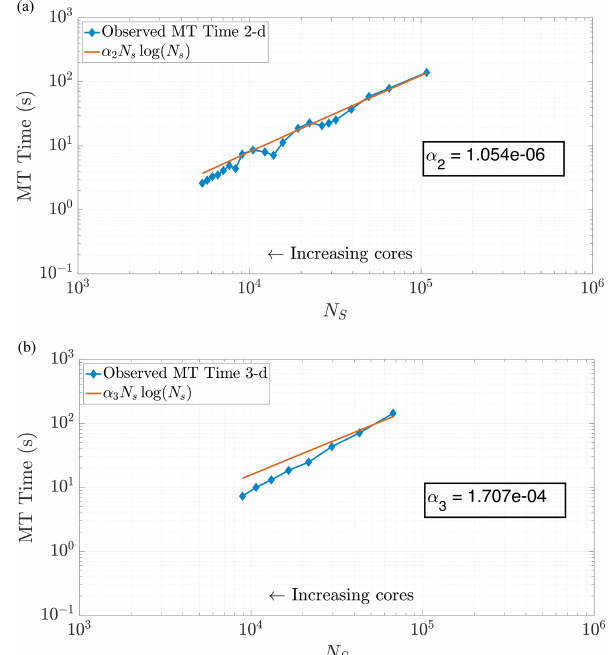
Figure 6. Plots of run time in the MT portion of benchmark runs. Note the similar behavior in both 2-D (a) and 3-D (b) for predicting MT subroutine run time, based on our theoretical run time scaling in Eq. (24). Using this prediction function achieves values of r 2 = 0 . 9780 in 2-D and r 2 = 0 . 9491 in 3-D. Axis bounds are chosen for ease of comparison to results in Figs. 7, 8, and